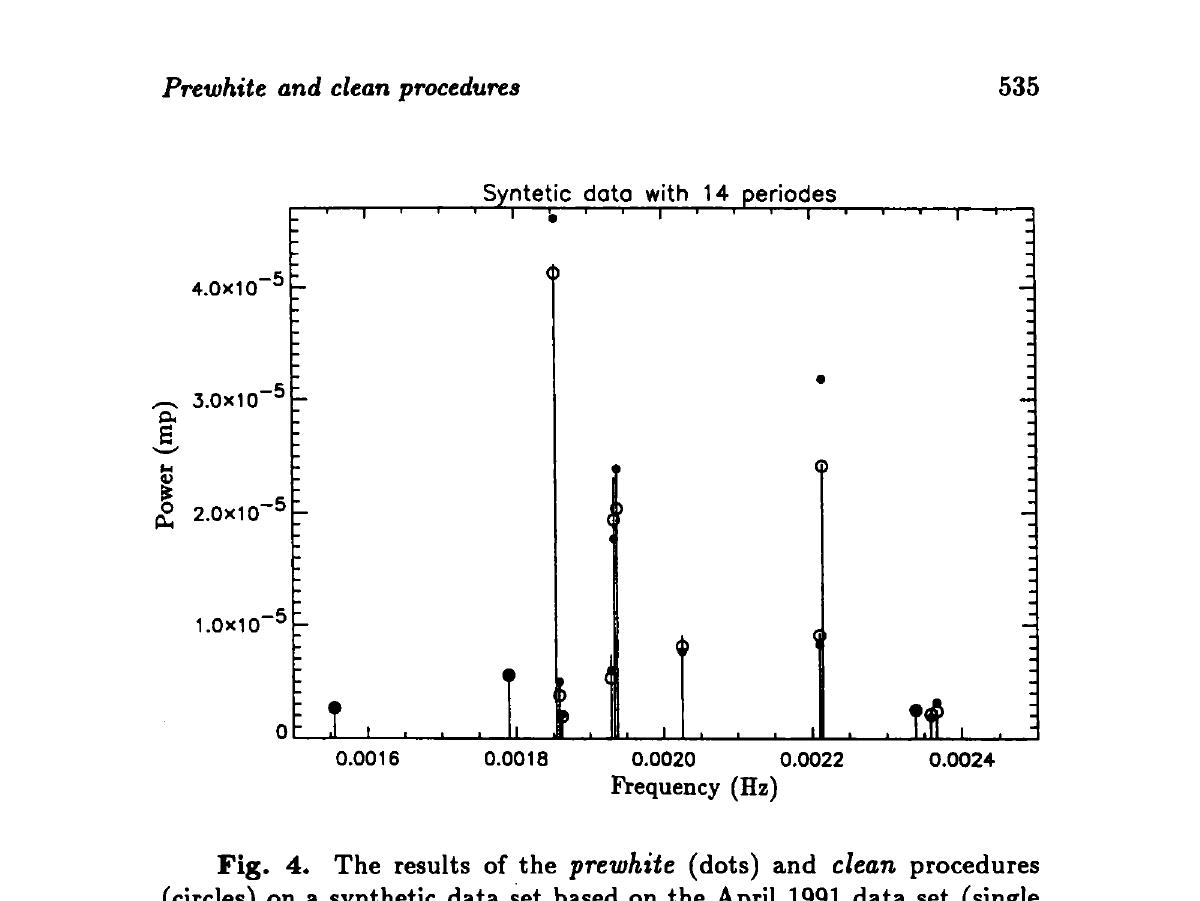
Fig. 4. The results of the prewhite (dots) and clean procedures (circles) on a synthetic data set based on the April 1991 data set (single site). Frequencies and amplitudes in the synthetic file are shown by